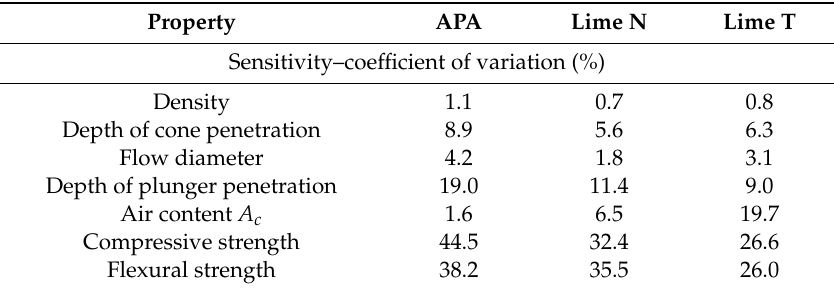
Table 23. The sensitivity of plaster properties to temperature changes.